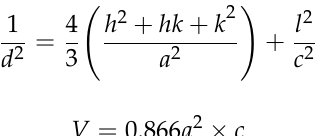
Figure 1. ( a ) : XRD pattern of pure, Co, Gd, and Co/Gd dual-doped nanoparticles of ZnO;( b ) XRD Figure 1. ( a ): XRD pattern of pure, Co, Gd, and Co/Gd dual-doped nanoparticles of ZnO; ( b ) XRD graph of (101) plane showing shifting of the peak towards lower angles. graph of (101) plane showing shifting of the peak towards lower angles. The crystal structure factor ( a and c ) and volume of the unit cell (V) of the pure and doped samples were estimated by using the subsequent equations